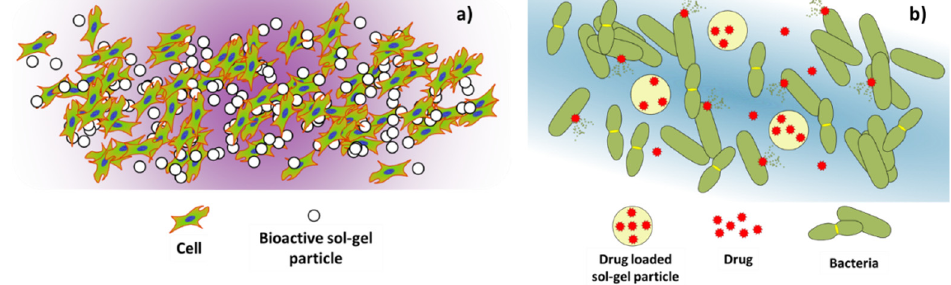
Figure 13. ( a ) Schematics of bioactive loaded sol-gel particles promoting cell proliferation and differentiation, ( b ) schematics of sol-gel particles releasing antibiotic drugs for hindering bacteria pro- liferation.